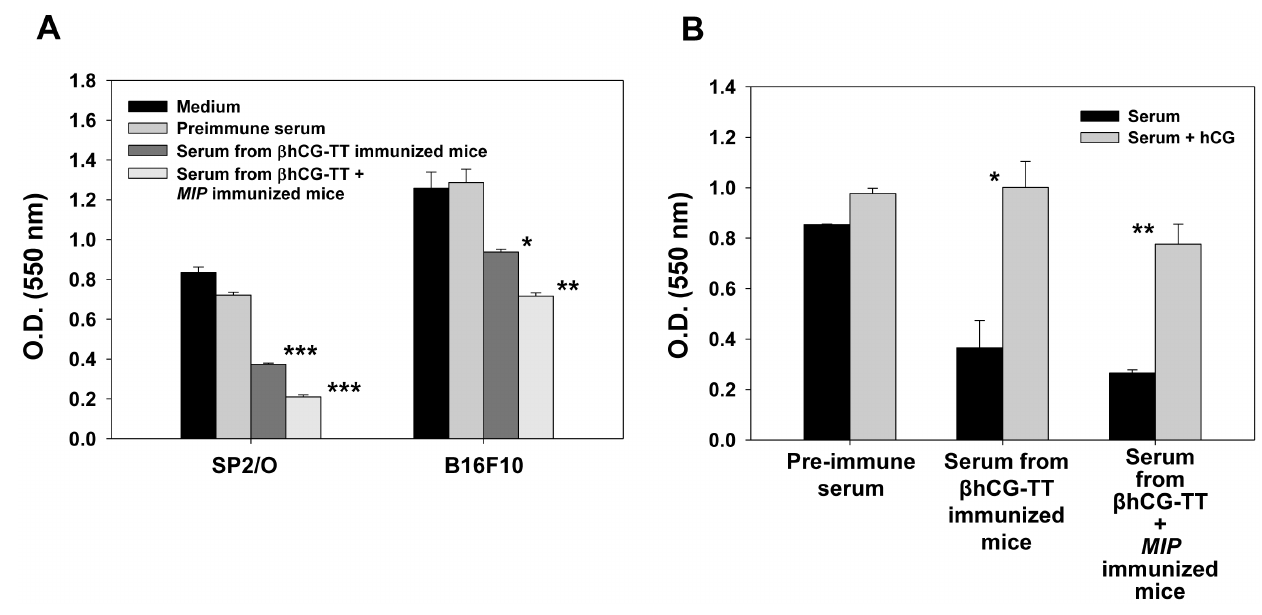
Figure 9. Effects of anti-sera on tumor cell viability. (A) The effects of pooled pre-immune serum and antiserum derived from mice immunized with b hCG-TT or b hCG-TT + MIP on the viability of SP2/O and B16F10 cells. Bars represent arithmetic mean 6 standard error. *p # 0.05, **p # 0.01, ***p # 0.001 versus pre-immune serum. (B) Effect of co-incubation with hCG (1 m g/ml) on the loss of viability of SP2/O cells induced by antiserum from mice immunized with b hCG-TT or b hCG-TT + MIP . Bars represent arithmetic mean 6 standard error. *p # 0.05, **p # 0.01versus serum alone.